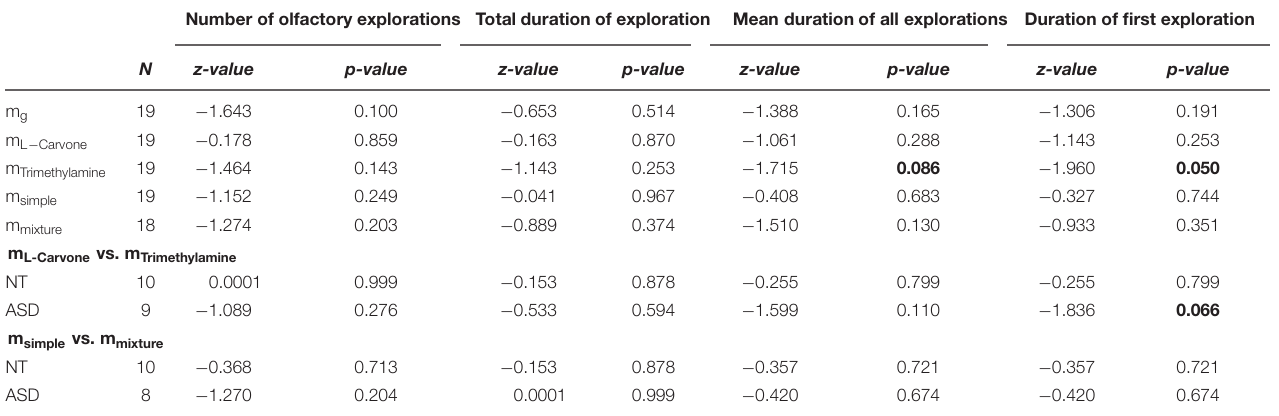
TABLE 2 | Inter-group and intra-group comparison for number of olfactory explorations, total duration of exploration, mean duration of all explorations and duration of first exploration: sample size ( N ), observed z -value and p -value for each parameter and each variable. Number of olfactory explorations Total duration of exploration Mean duration of all explorations Duration of first